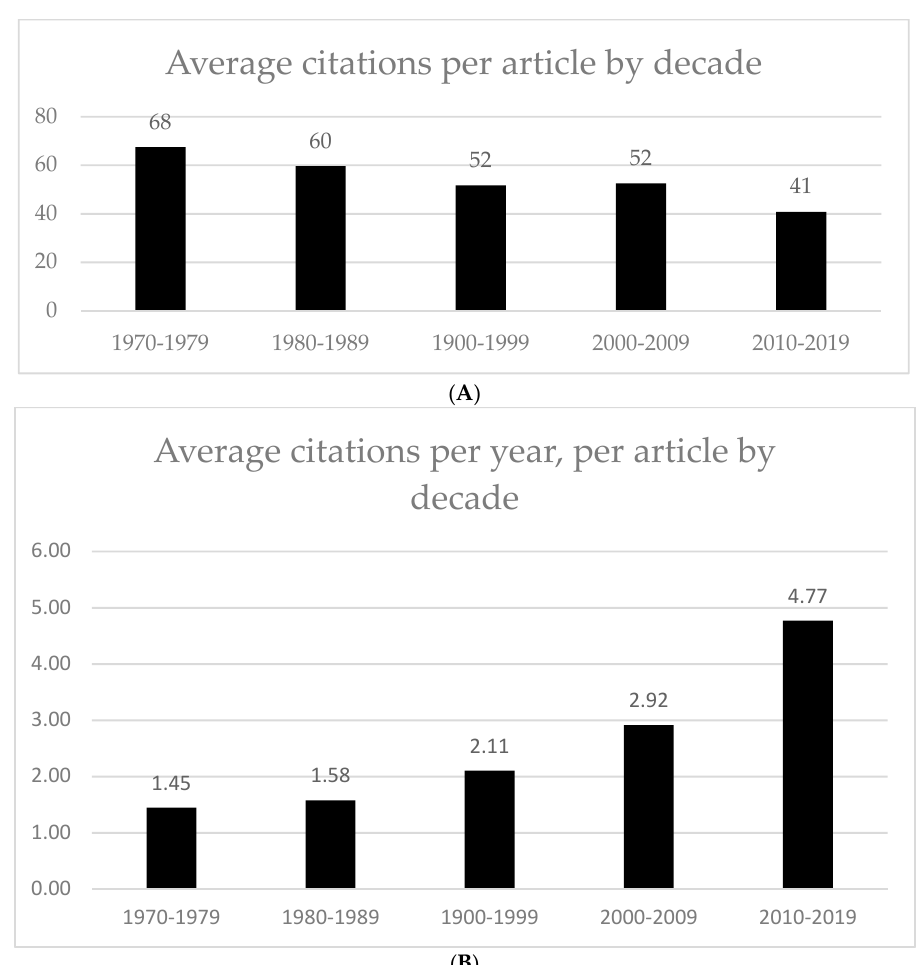
Figure 2. ( A ) Average citations per article by decade. ( B ) Average citations per year, per article by decade. Calculated by number of citations, divided by number of years since publications (using 2022 as the index year). This was then averaged over the articles published within each decade as shown. Table 4. Top 8 most productive authors .